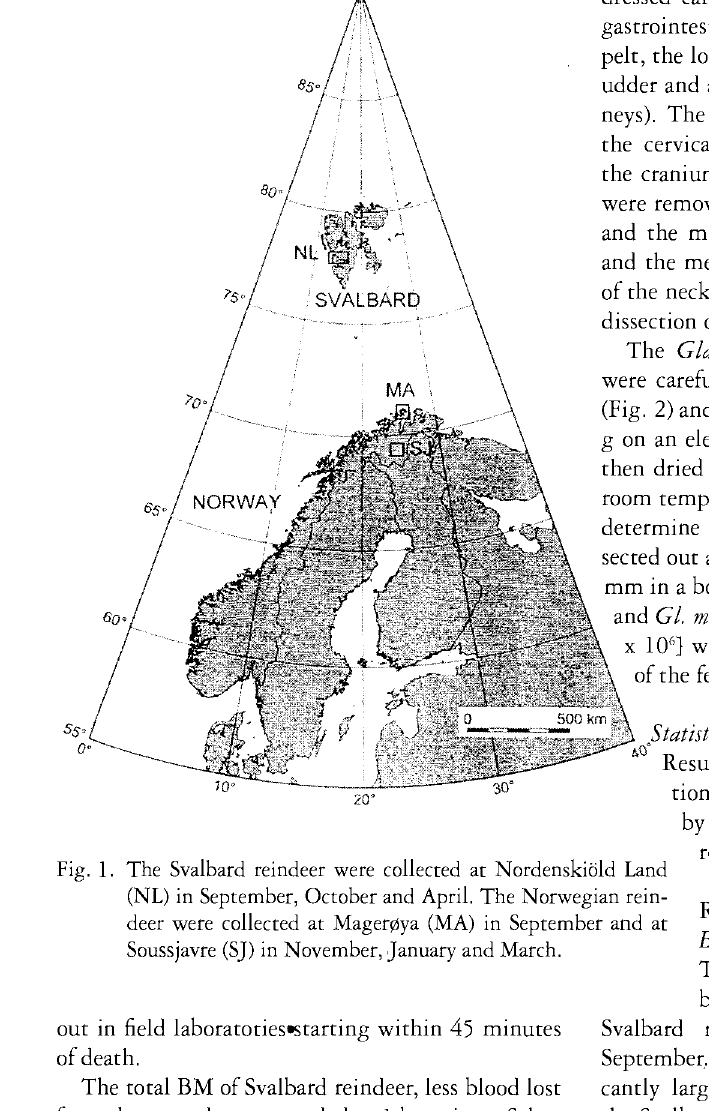
Fig. 1. The Svalbard reindeer were collected at Nordenskiold Land (NL) in September, October and April. The Norwegian rein deer were collected at Magerøya (MA) in September and at Soussjavre (SJ) in November, January and